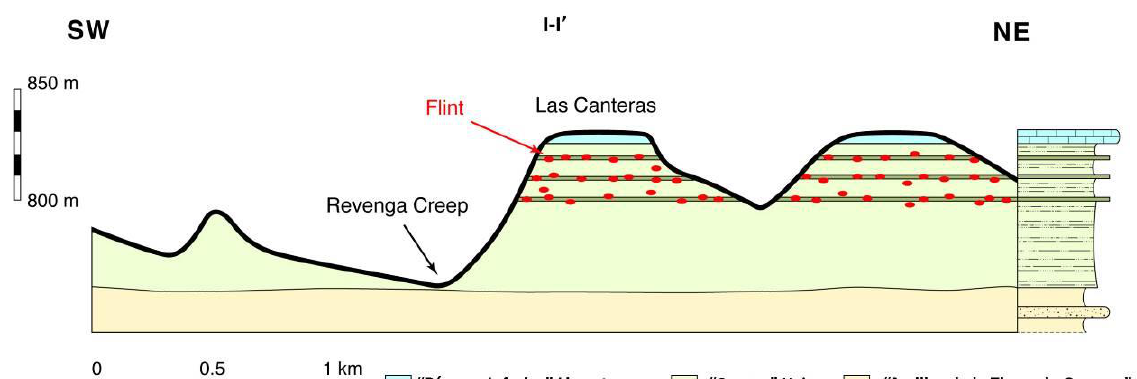
Figure 3. Geological cross-section in the area of Las Canteras (Mucientes, Valladolid), as indicated in Figure 4.